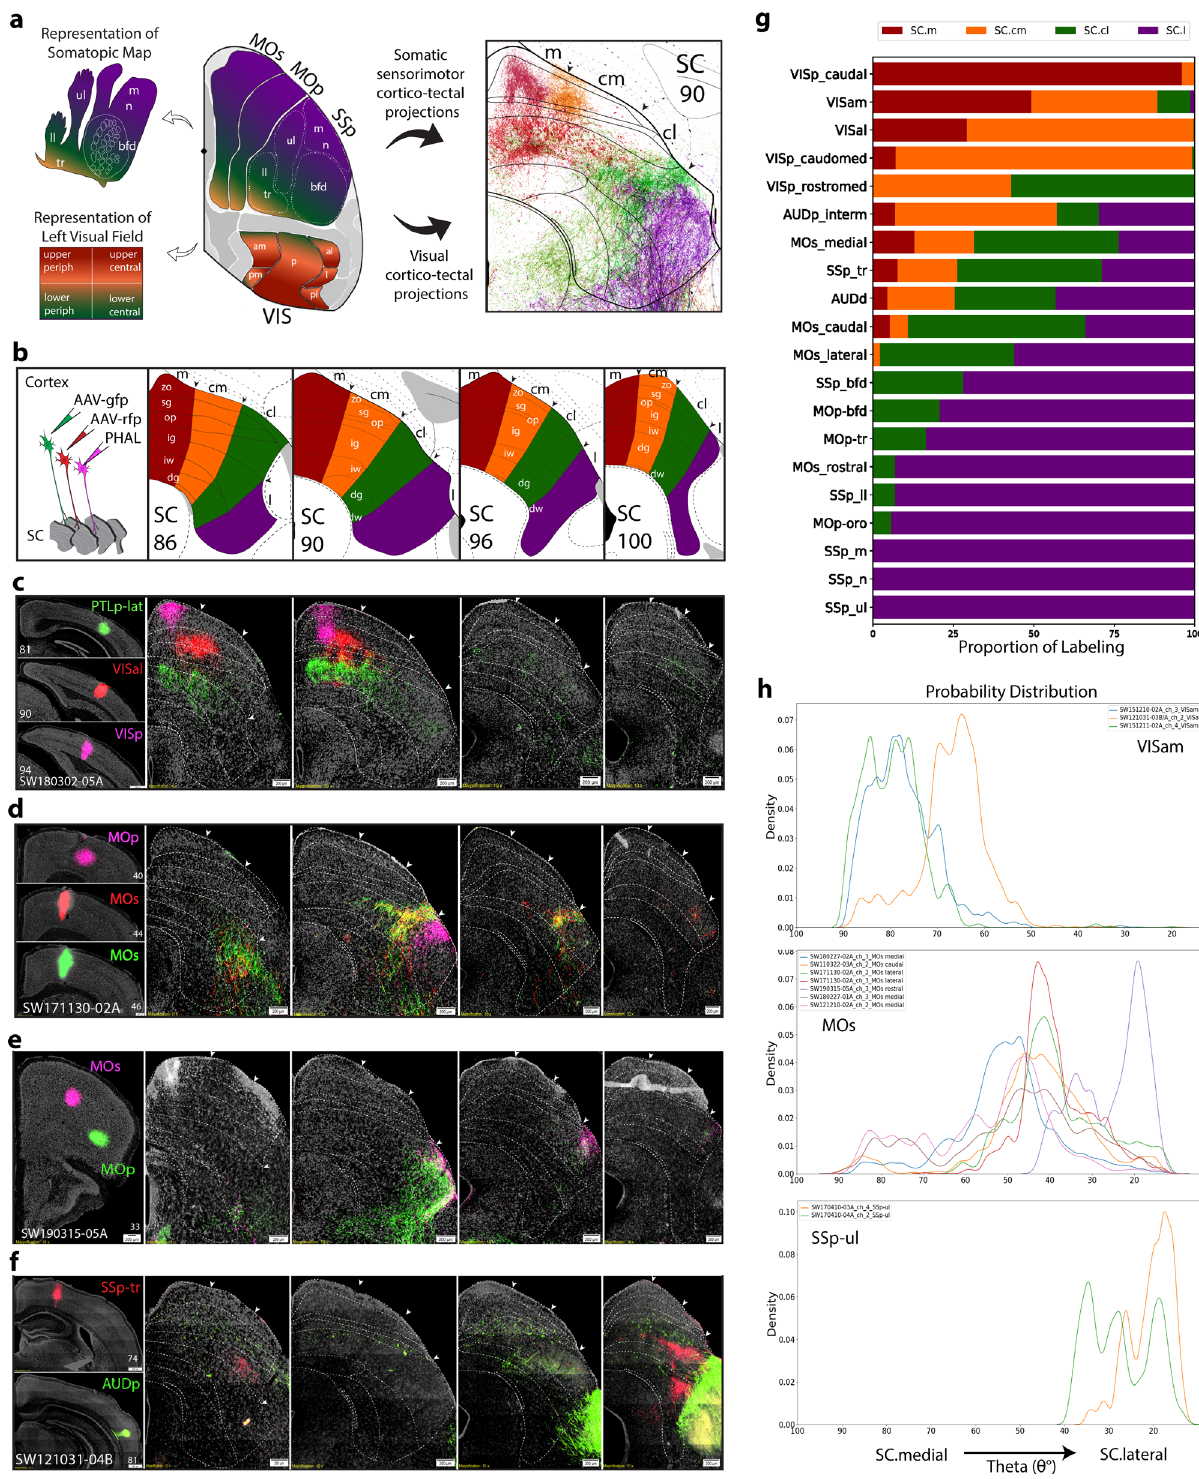
illustrating the overlap and similarities of projection pro fi les for multiple cortical cases within distinct ranges of SC. Probability distribution plots show individual cortical projections that target distinct zones (SC.m ( n = 7), SC.cm ( n = 4), SC.cl ( n = 12),